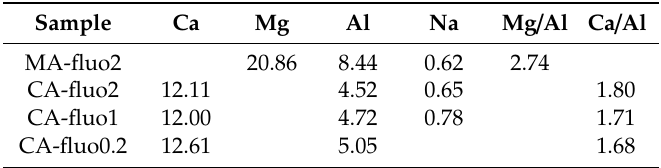
Table 1. Element chemical analysis data (% w / w ) of the synthesised samples and molar ratios of layer cations. All values rounded to two decimal